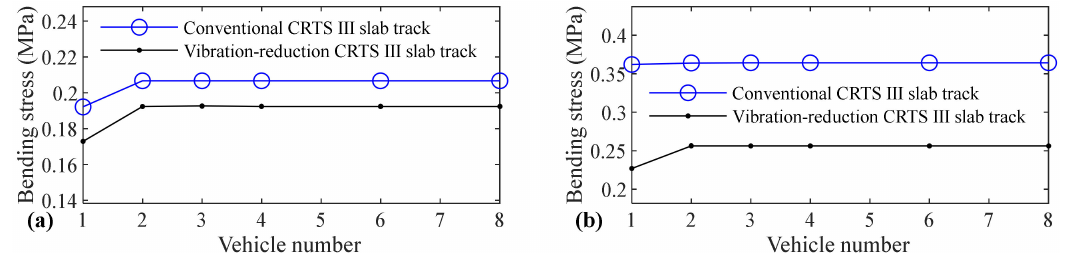
Figure 15. Relation between vehicle number and positive bending stress of concrete base: ( a ) without and ( b ) with random track irregularity.